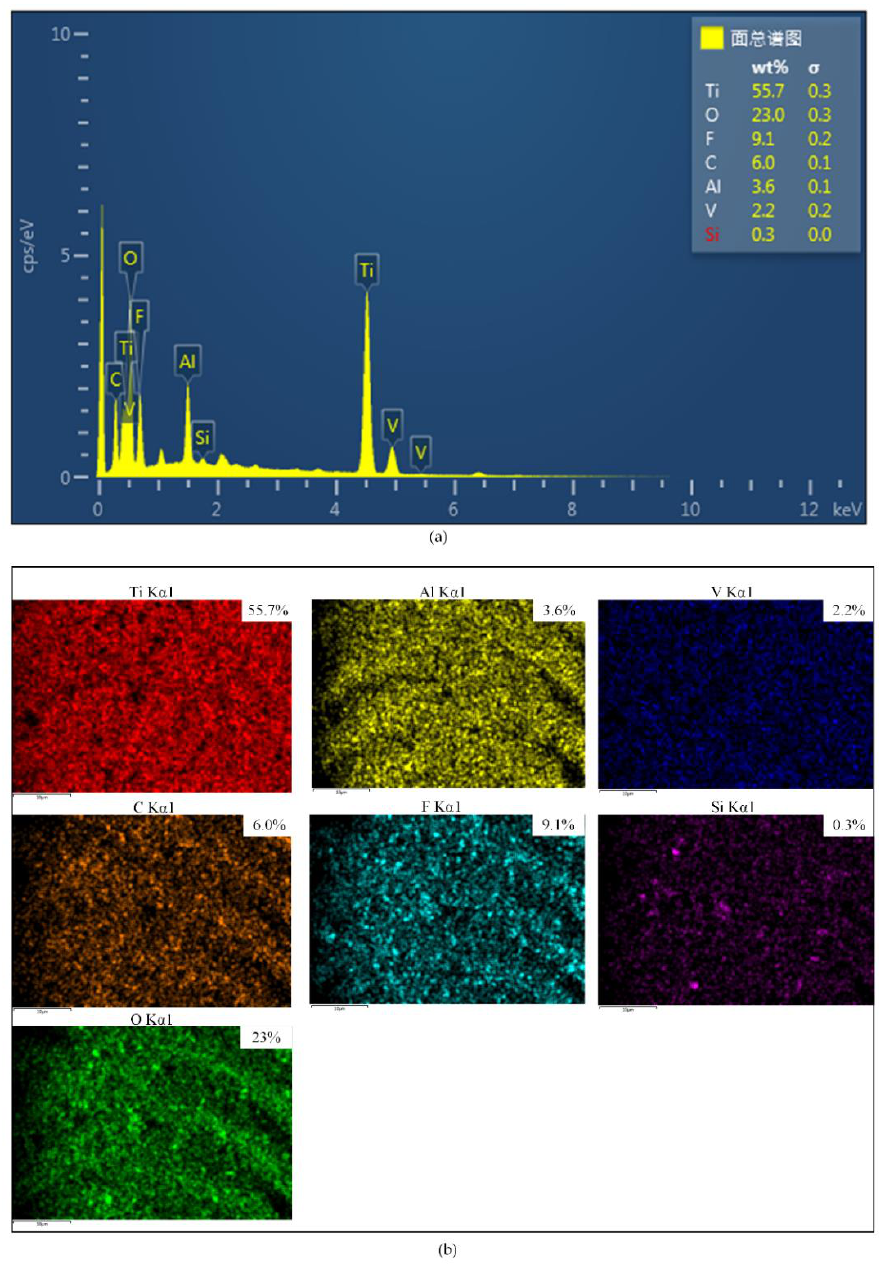
Figure 4. ( a ) Energy-dispersive spectroscopy (EDS) spectra of F Ti. ( b ) Surface chemical element distribution images of F Ti.